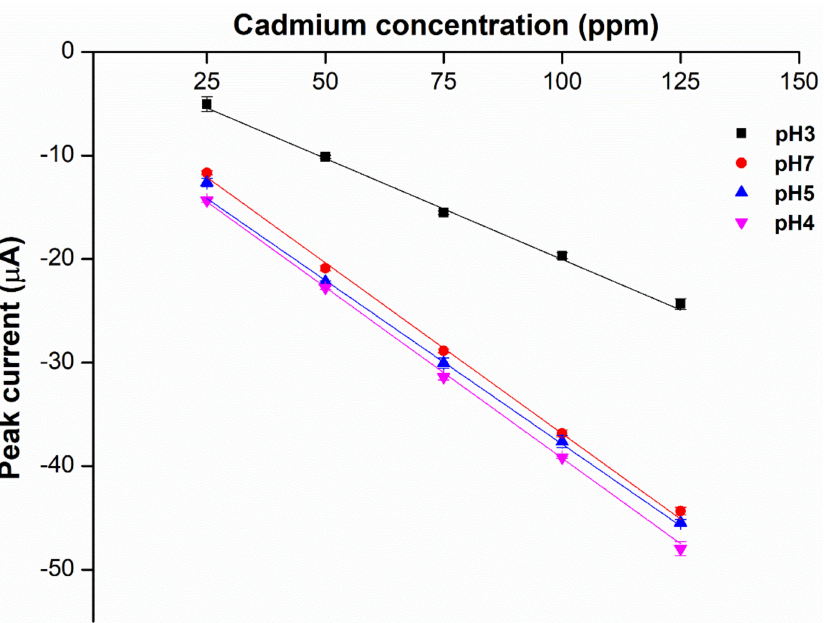
Figure 7. Effect of different pH using HCl on the sensitivity of the hybrid plasticizer sensor ( n = 5).